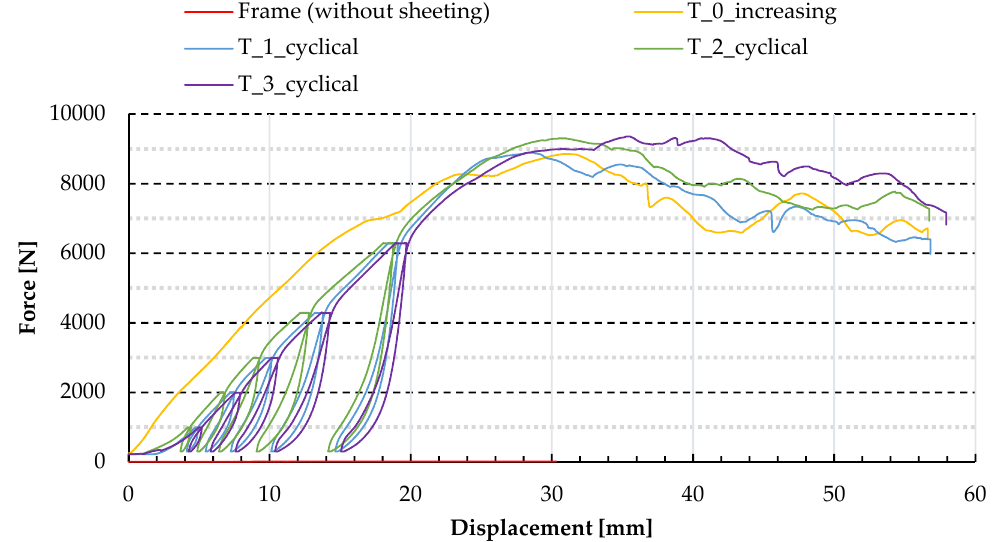
Figure 6. Force–displacement paths obtained in experimental tests.